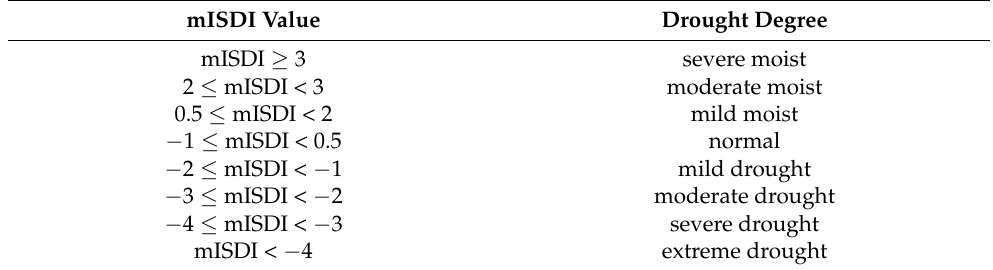
Table 5. Classification of drought severity for the monthly integrated surface drought index (mISDI). mISDI Value